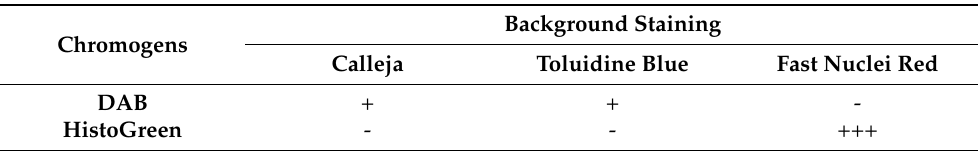
Table 2. Contrast between chromogens and background staining in calcium caseinate 2.5% model